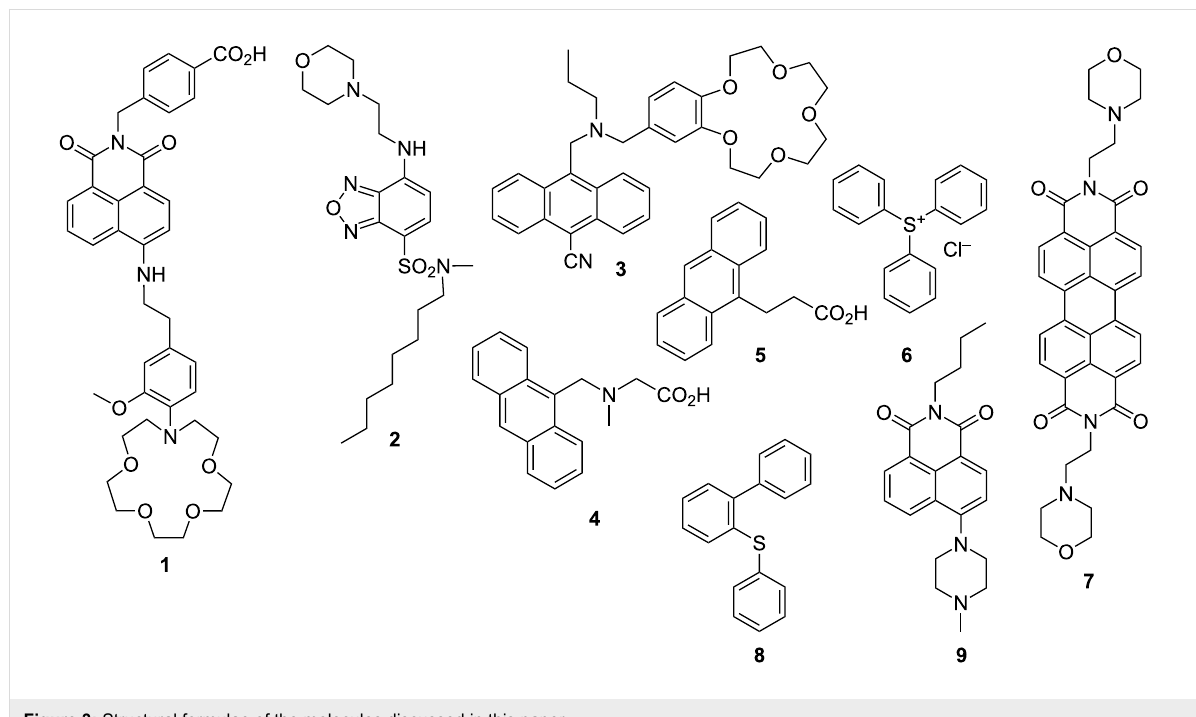
Figure 3: Structural formulae of the molecules discussed in this paper.